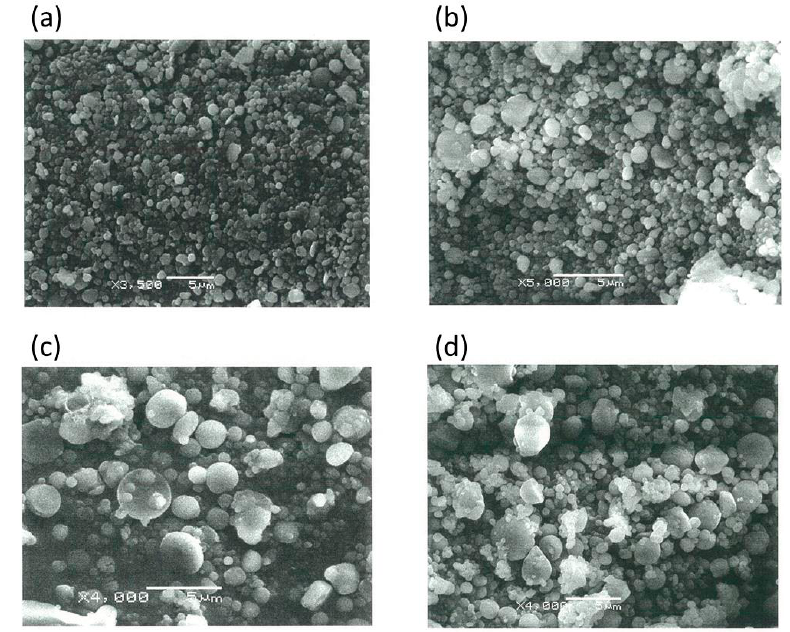
Figure 2. Scanning electron micrographs of ( a ) Ch-TBA-MP; ( b ) Ch-TBA/TMC-MP *; ( c ) Ch-TBA-MP/Eud; and ( d ) Ch-TBA/TMC-MP/Eud *. * Ch-TBA/TMC(4/1)-MP were used. The length of the white bar = 5 µm. MP: microparticles. Table 2. Particle characteristics of Ch-TBA-MP/Eud, Ch-TBA/TMC-MP/Eud, a nd Ch-MP/Eud. Preparation